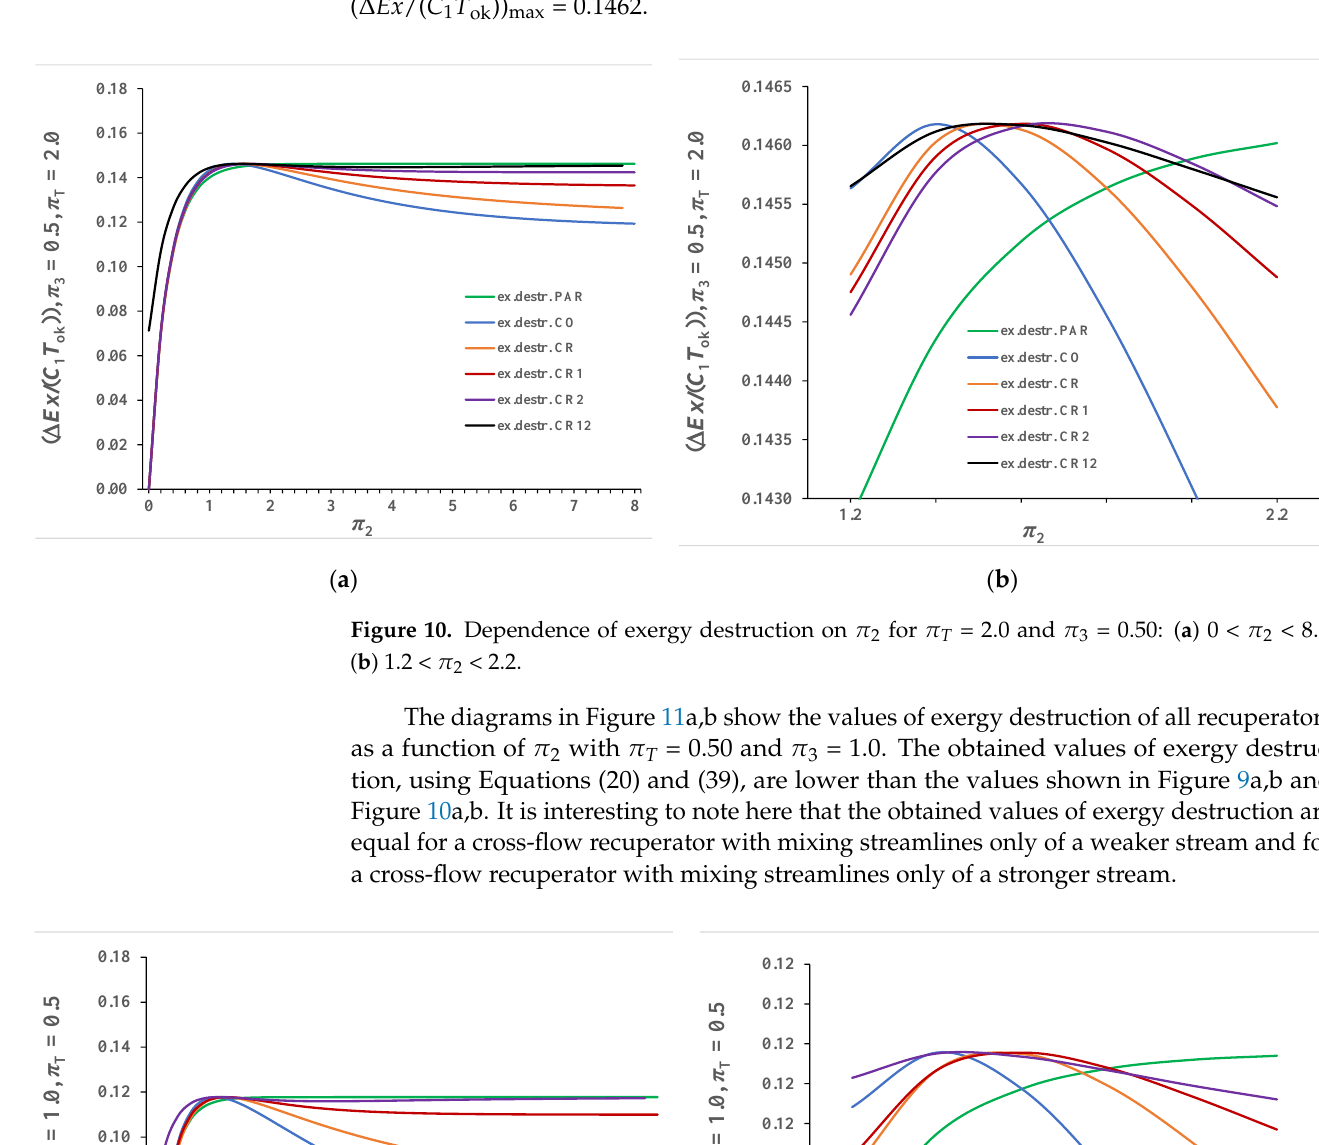
value of exergy destruction decreased, which in this case, according to Equation (40), equals ( ∆ Ex /( C 1 T ok )) max = 0.1462.